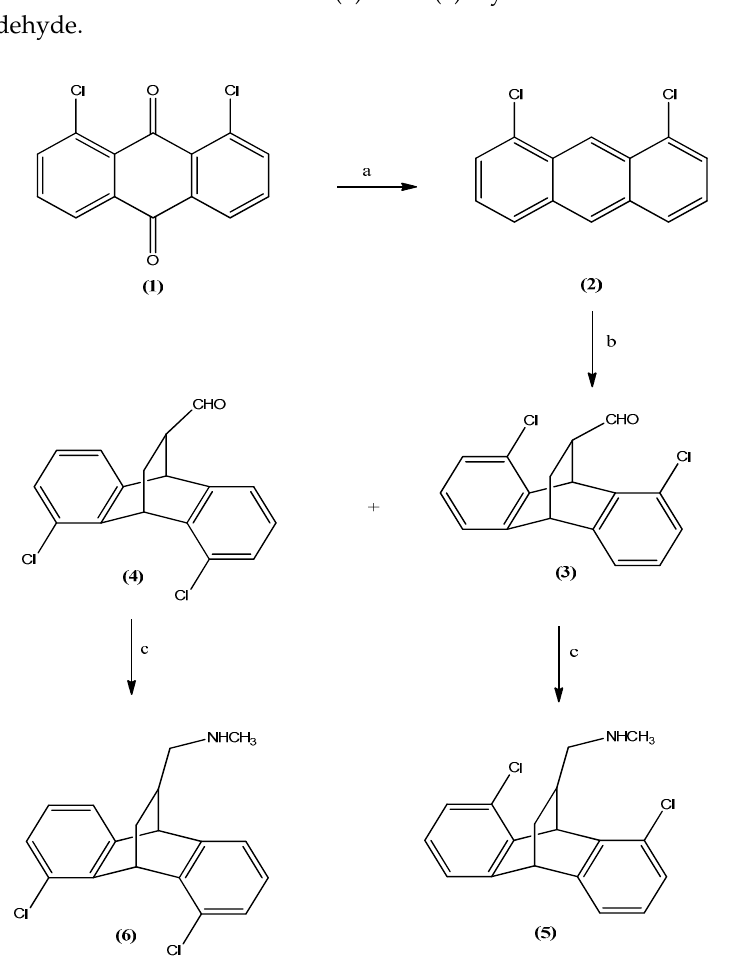
Figure 1. Benzoctamine, maprotiline and targeted